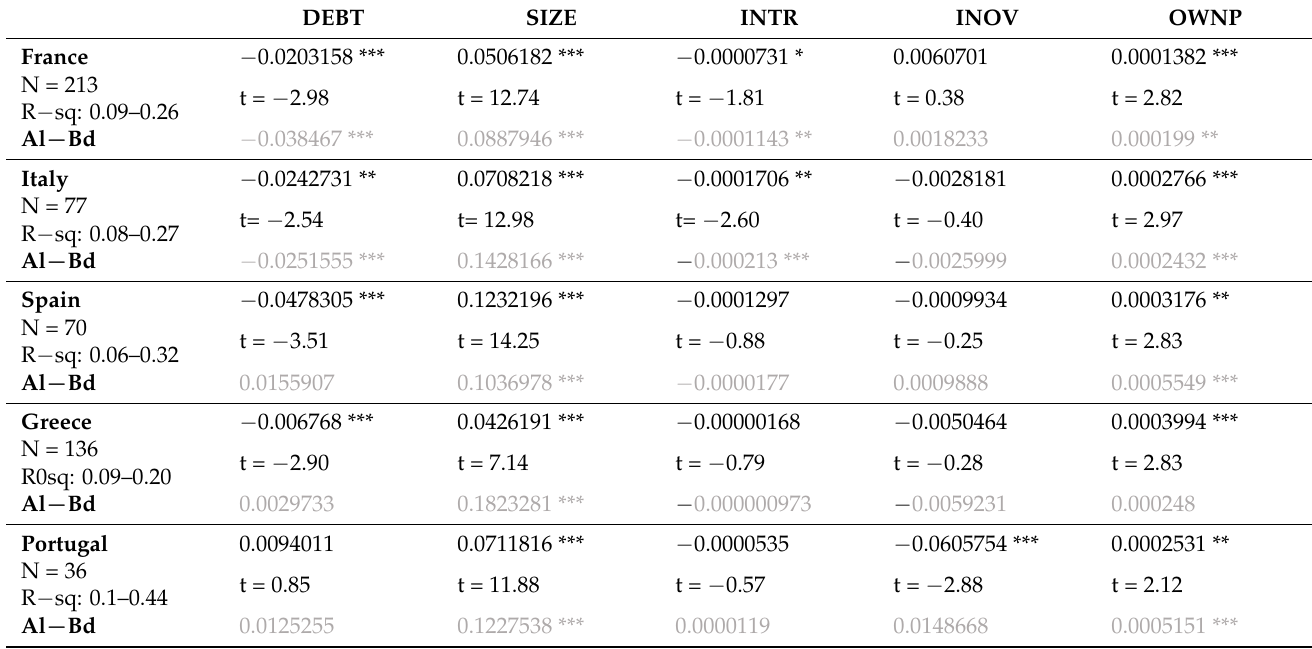
Table 1. Summarized results of the panel data analysis for empirical model